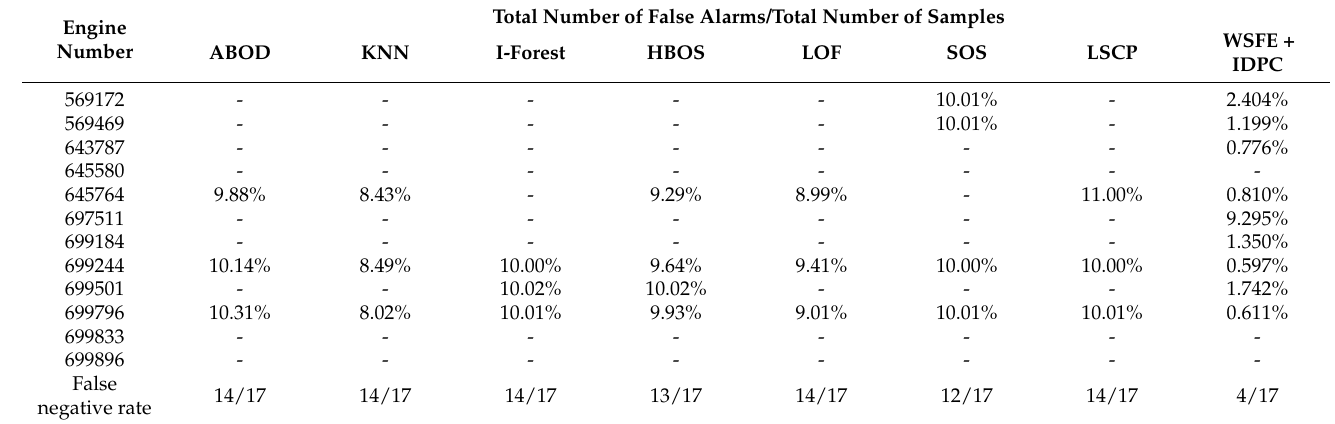
Table 9. Anomaly detection results of the state-of-the-art